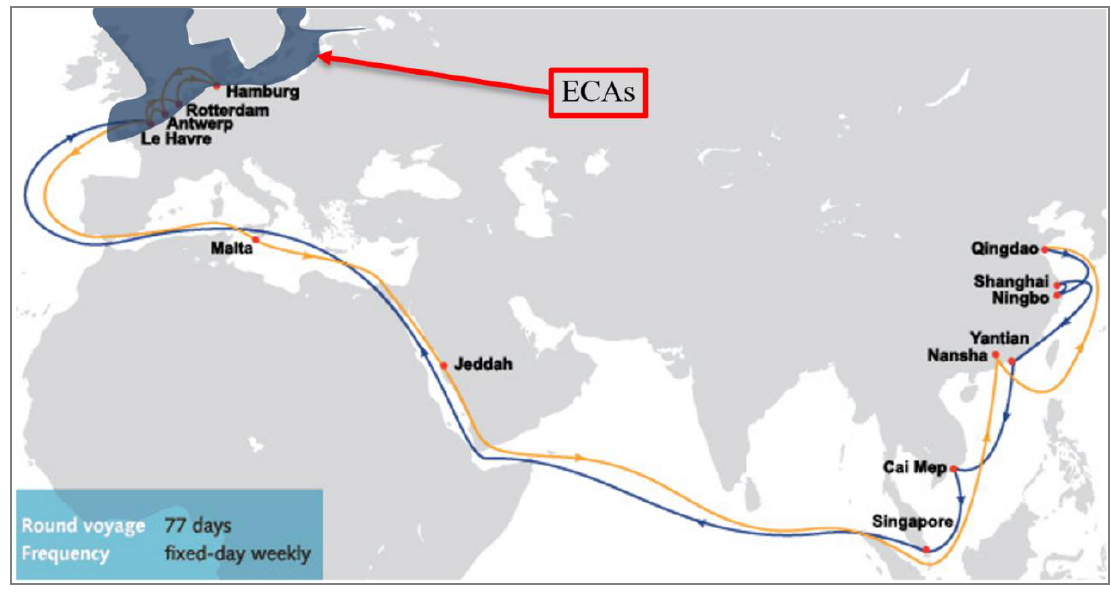
Figure 5. The Asia–North Europe LL5 route.